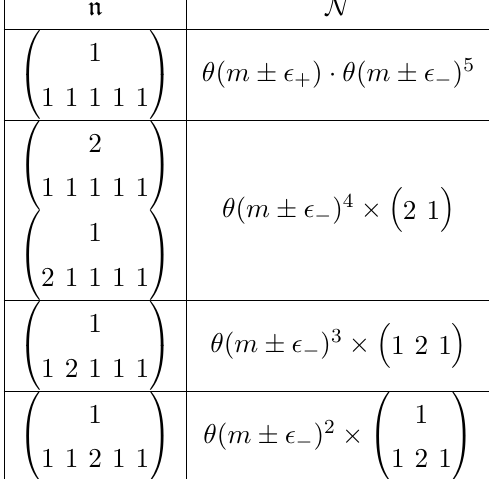
Table 6 . Elliptic genera of E 6 .